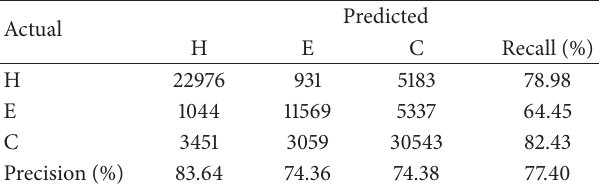
Table 7: Confusion matrix without filtering.